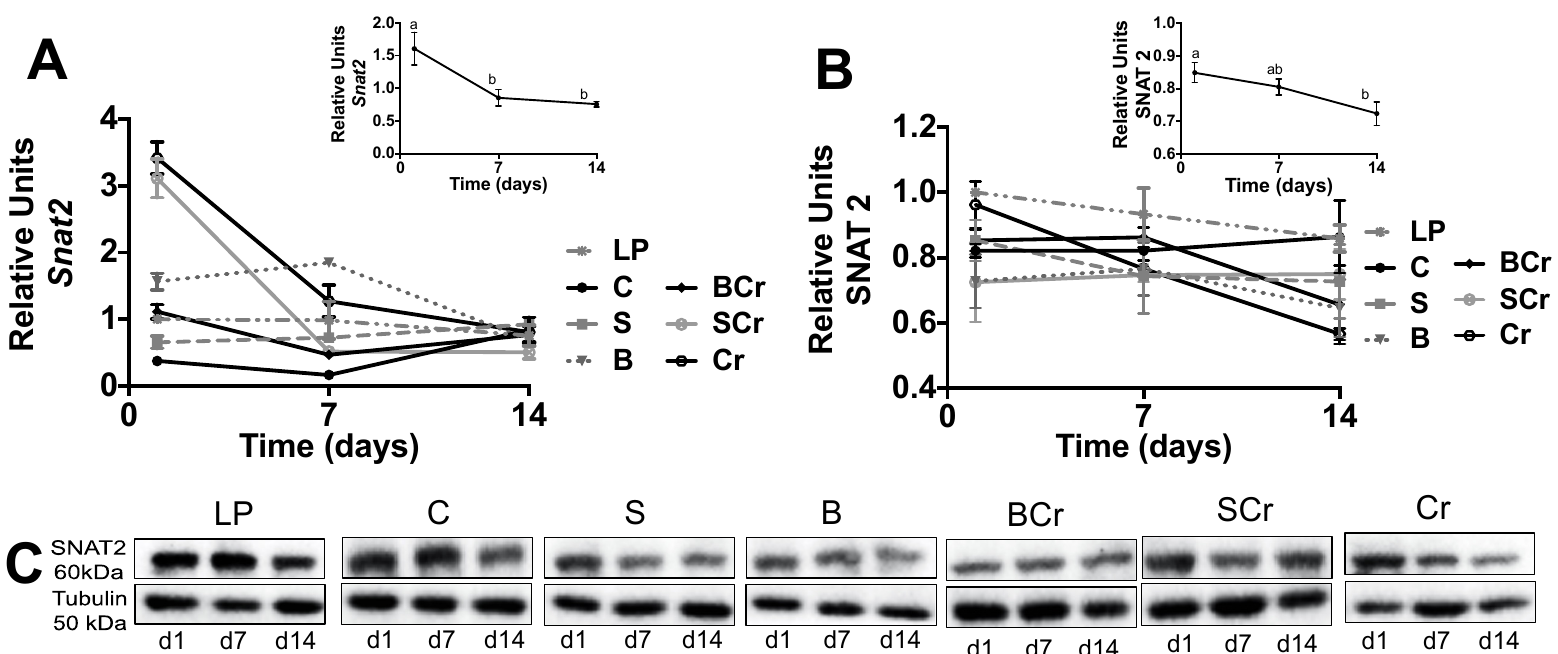
Figure 6. mRNA gene expression and Western blot analysis of SNAT2 in liver of rats fed different types of proteins after a protein restricted period: ( A ) Snat2 mRNA abundance; ( B ) protein abundance of Snat2 ; and ( C ) representative Western blot analysis. Values are means ± SEM, n = 3. Different letter superscript indicates significant differences among time, p < 0.05, a > b > c.